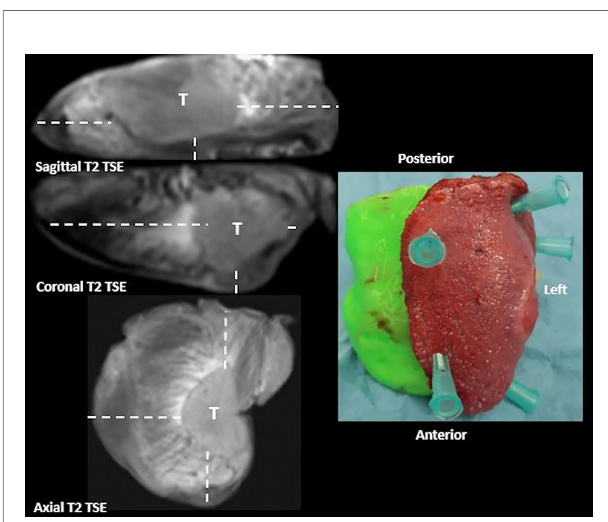
FIGURE 5 | Coronal, sagittal, and axial T2 TSE MRI sequences of the surgical specimen oriented on a 3D-printed model. Multiplanar MRI sequences show the tumor (T) and its macroscopic radial distance (dotted line) from the surface of the specimen in all the